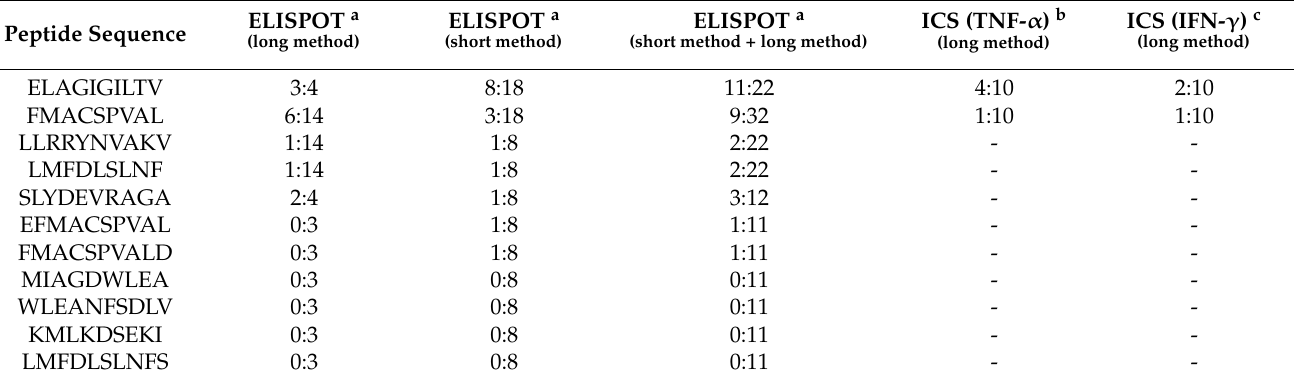
Table 2. In vitro generation of CD8 + T cells specifically recognizing the SOX11-derived peptides. ELISPOT a Peptide Sequence (long